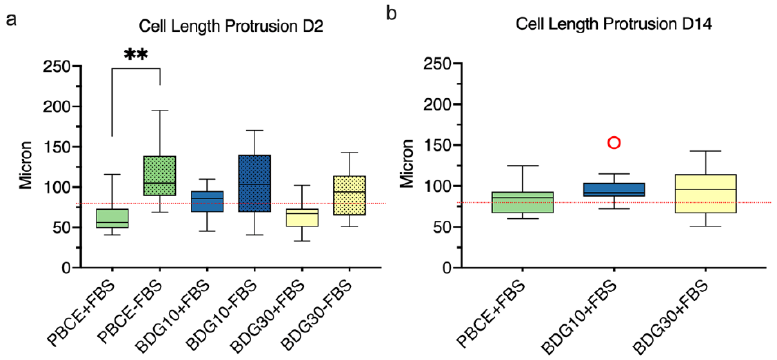
Figure 8. Quantitative measurements of the cell protrusion on PBCE, BDG10 and BDG30. ( a ) Comparison of the cell protrusion length between stem cells grown on PBCE-films and CTR cultures on D2 in proliferation medium in the presence ( + ) and absence ( − ) of FBS. ( b ) Measurement of cell protrusion length in stem cells grown on polymer films on D14 in proliferation medium in the presence of FBS. Red circles: outliers. The results are expressed as the mean of three independent experiments, ** p < 0.01.